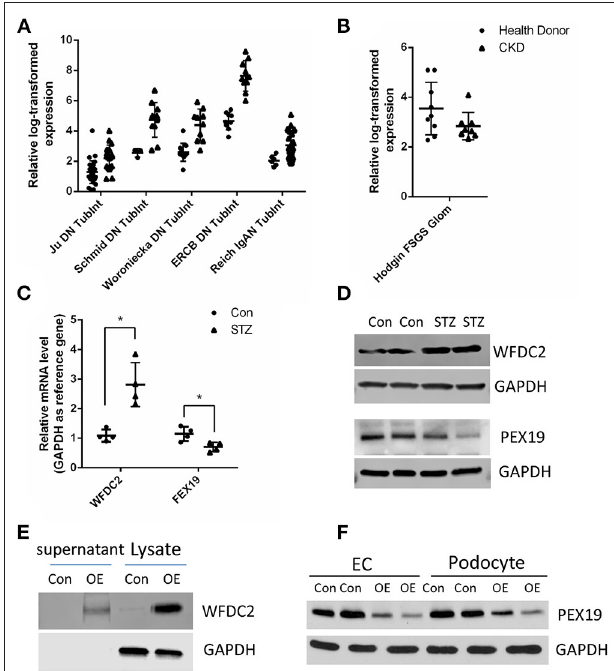
FIGURE 5 | Verification of WFDC2 and PEX19 interaction in HK2, podocyte, and glomerular endothelial cells. (A) Relative WFDC2 transcript levels were upregulated in many diabetic nephropathy human and mice datasets in the kidney tubule. (B) Relative FEX19 transcript levels were downregulated in FSGS in the kidney glomeruli in Nephroseq database. (C,D) WFDC2 in the tubule was upregulated, and FEX19 in the glomeruli was downregulated in STZ-induced diabetic mice by qPCR and western blot. (E) Western blot shows WFDC2 overexpression in HK2 cell. (F) PEX19 protein level was decreased with WFDC2 treatment in podocyte and glomerular endothelial cells by western blot. Con, WFDC2 empty vector; OE, WFDC2 overexpression vector; EC, glomerular endothelial cells. (A–C) Values are mean ± SEM; * p ≤ 0.05 between means. (A,B) All the genes were significantly changed in CKD compared with control with p <